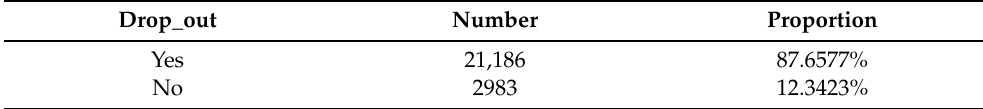
Table 3. The descriptive statistics about the classes of the dependent